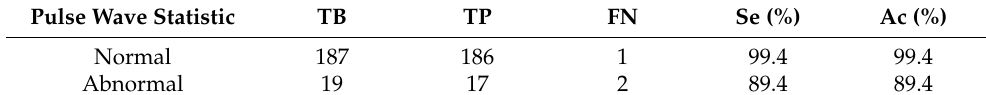
Table 2. Results of analyzing the pulse wave signal of PAC patients.